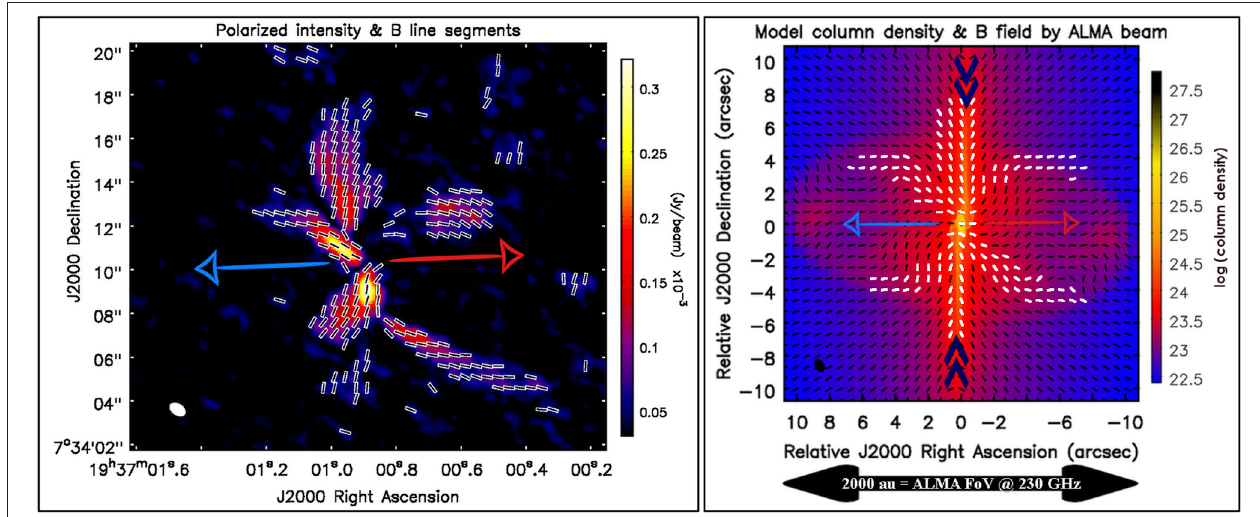
FIGURE 1 | An example of the magnetic field traced by dust polarization around an observation (left-hand panel) and a numerical model (right-hand panel) of the solar-type Class 0 protostar B335. The background image in the right-hand panel is the ALMA polarized dust continuum emission, and the superimposed lines infer the magnetic field orientations (i.e. the polarization angle rotated by 90 ◦ ). This figure is inspired by Figures 1 and 3 of Maury et al. (2018), and was created by A. J. Maury for this publication.